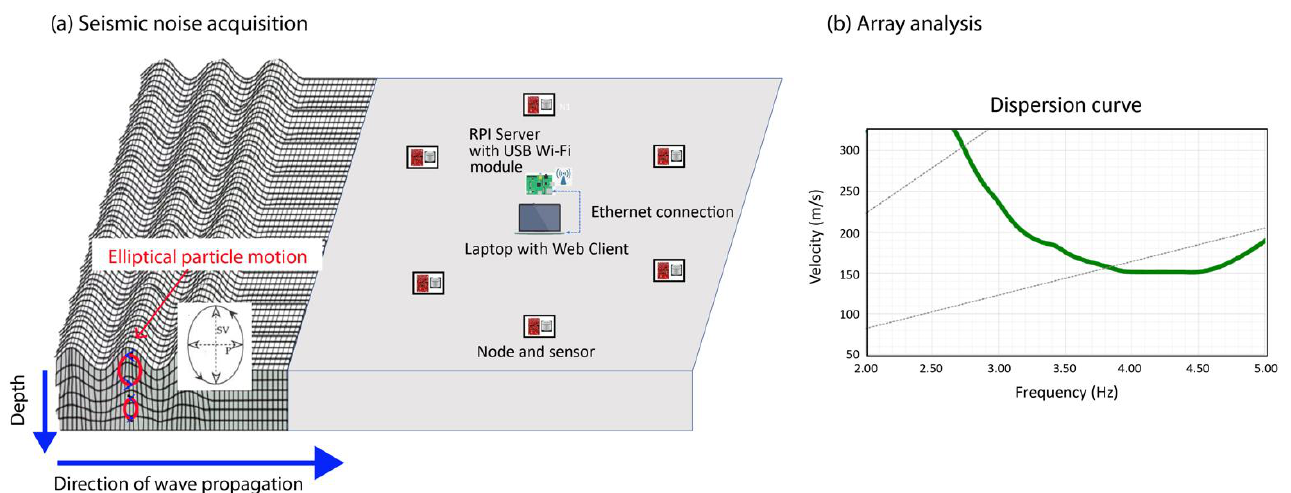
Figure 1. ( a ) General scheme of the seismic noise acquisition and the array deployment ( b ) Example of the result obtained after the analysis, i.e., dispersion curve.